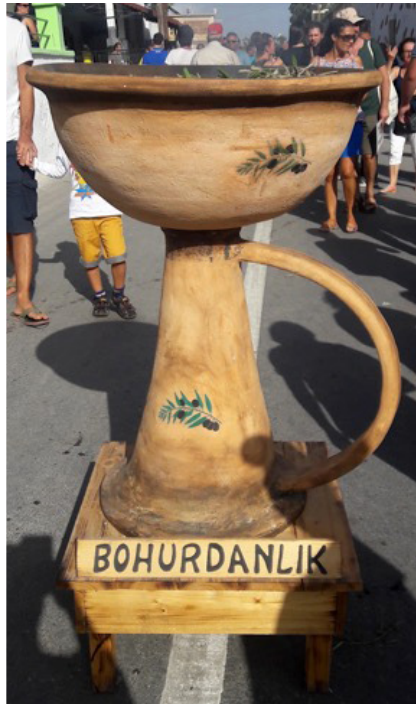
Figure 1. Buhurdanlik . Photograph by the